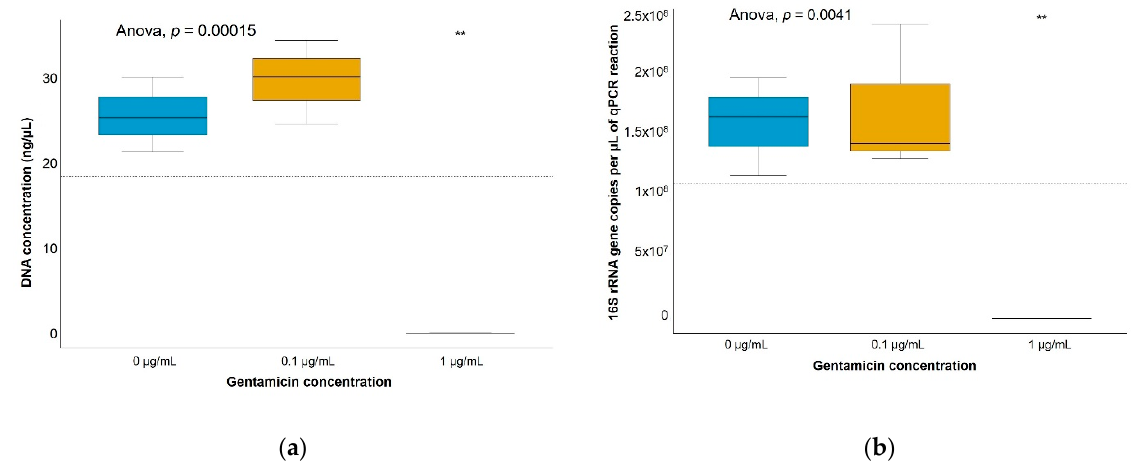
Figure 2. Gentamicin effect on soil bacterial growth in 1:10 TSB medium enrichments after 24-h exposure. ( a ) DNA concentrations and ( b ) number of 16S rRNA gene copies/µL of quantitative-PCR (qPCR) reaction. Significant differences between each group (each gentamicin concentration) and the average between all groups (horizontal dashed line) were determined by a t-test. ** p -value ≤ 0.01. n = 3.